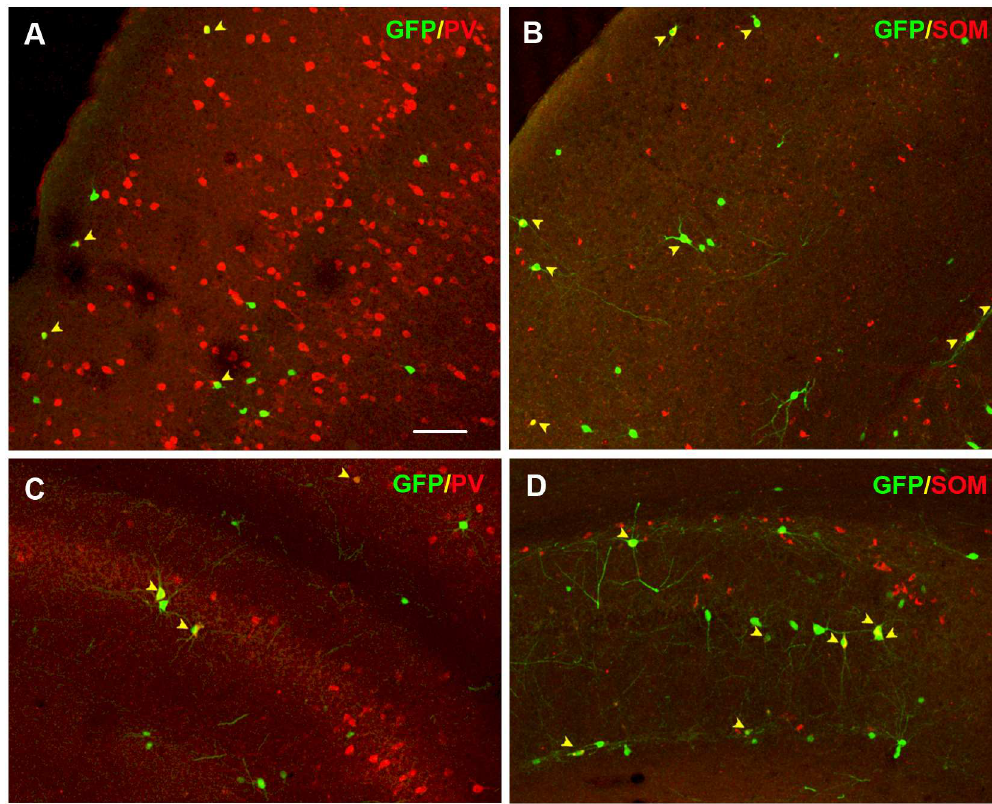
Fig 6. Interneuron sub-type differentiation of MGE-derived in toto cryopreserved cells after transplantation. Immunohistochemicalcolocalization of MGE in toto cryopreserved GFP + cells with the interneuron subtype markers PV (A, C) and SOM (B, D) in the cerebralcortex (A-B) and hippocampus (C-D). Arrowheads show double-positive cells. Scale bar 100 μ m.